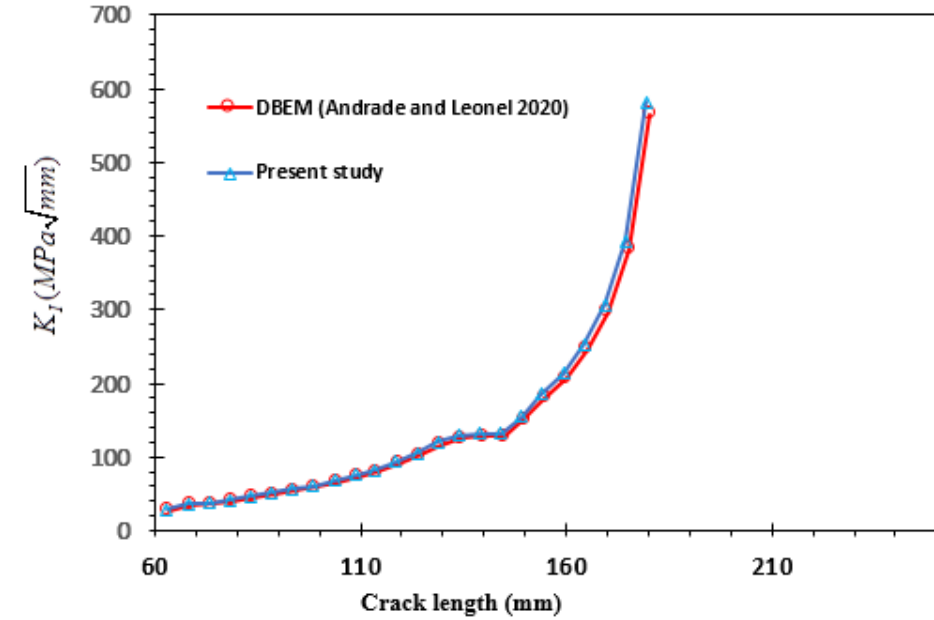
Figure 18. Comparison for the first mode of SIF ( K I ) for specimen 5.